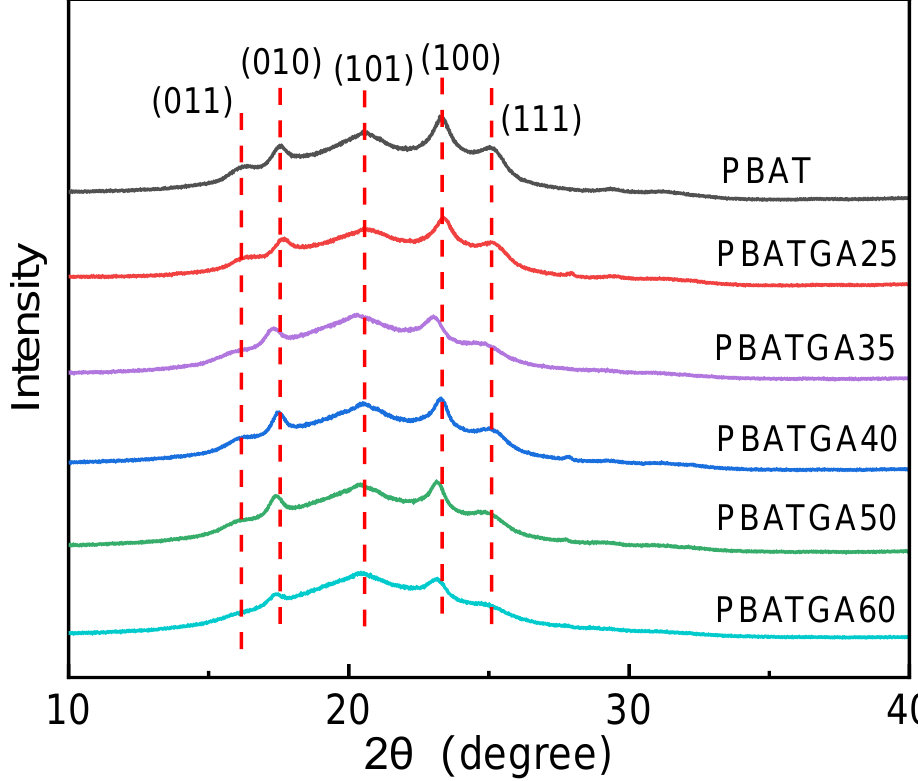
Figure 4. WAXD patterns of PBATGAs.